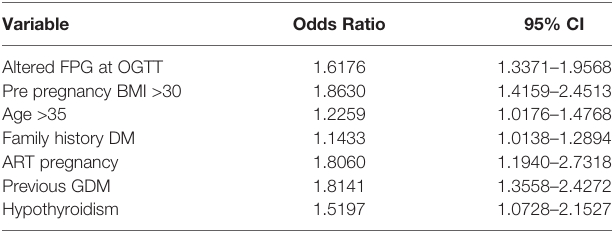
TABLE 3 | Variables signi fi cantly associated to insulin treatment for GDM from multivariate stepwise logistic regression. Variable Odds Ratio 95% CI